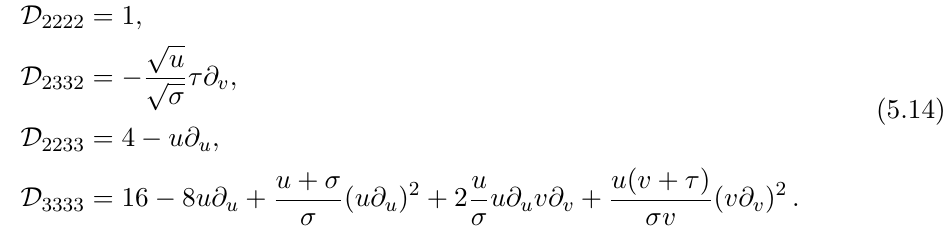
acting 1 p 2 p 3 p 4